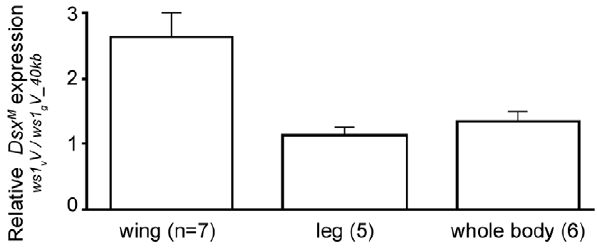
Figure 4. Change in doublesex expression due to ws1. Expression level change was estimated by quantitative RT–PCR. Note that the vitripennis dsx protein-coding region is present in both genotypes (i.e., the giraulti region of ws1 g V_40kb does not include the dsx coding sequence). Mean expression ratios 6 standard errors are shown. Expression ratios greater than 1 indicate higher male dsx ( dsx M ) transcript level in ws1 v V than in ws1 g V_40kb . Sample size indicates number of independent biological